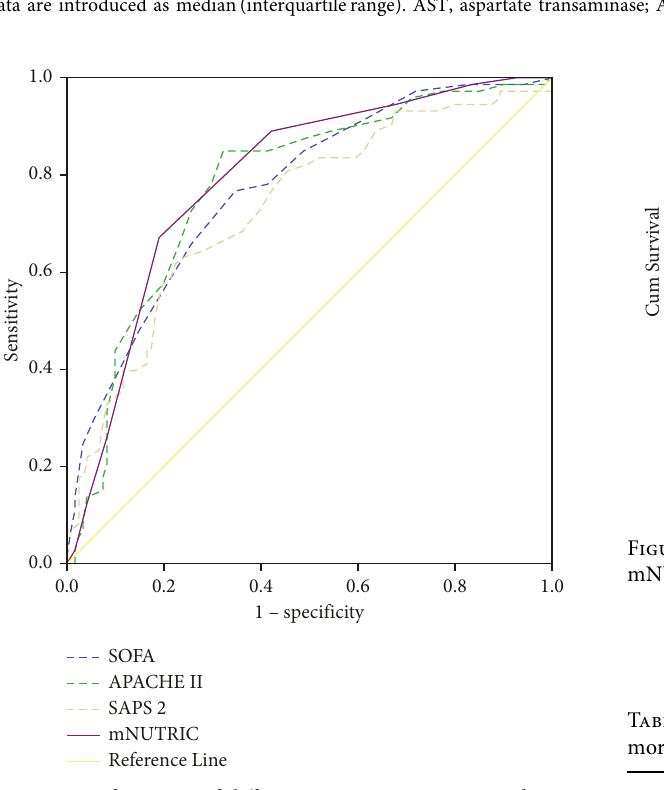
Figure 2: Performance of different scoring systems to predict in- hospital mortality in septic patients. Table 3: The performance of different variables for predicting mortality.